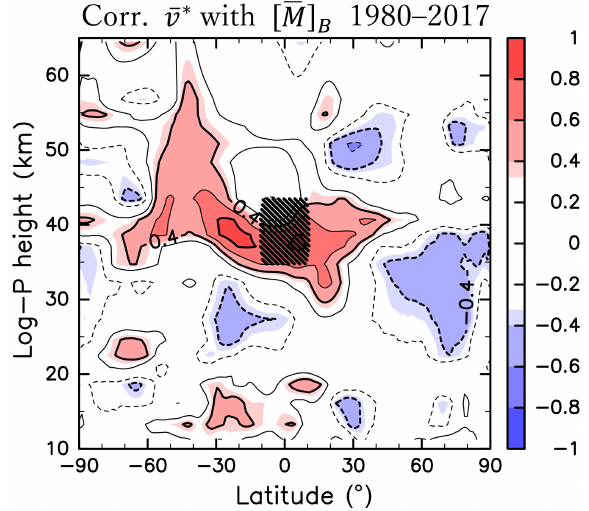
Figure 6. Same as Fig. 2 but for the correlation between [ M ] B and v ∗ (1980–2017). Region B is indicated by